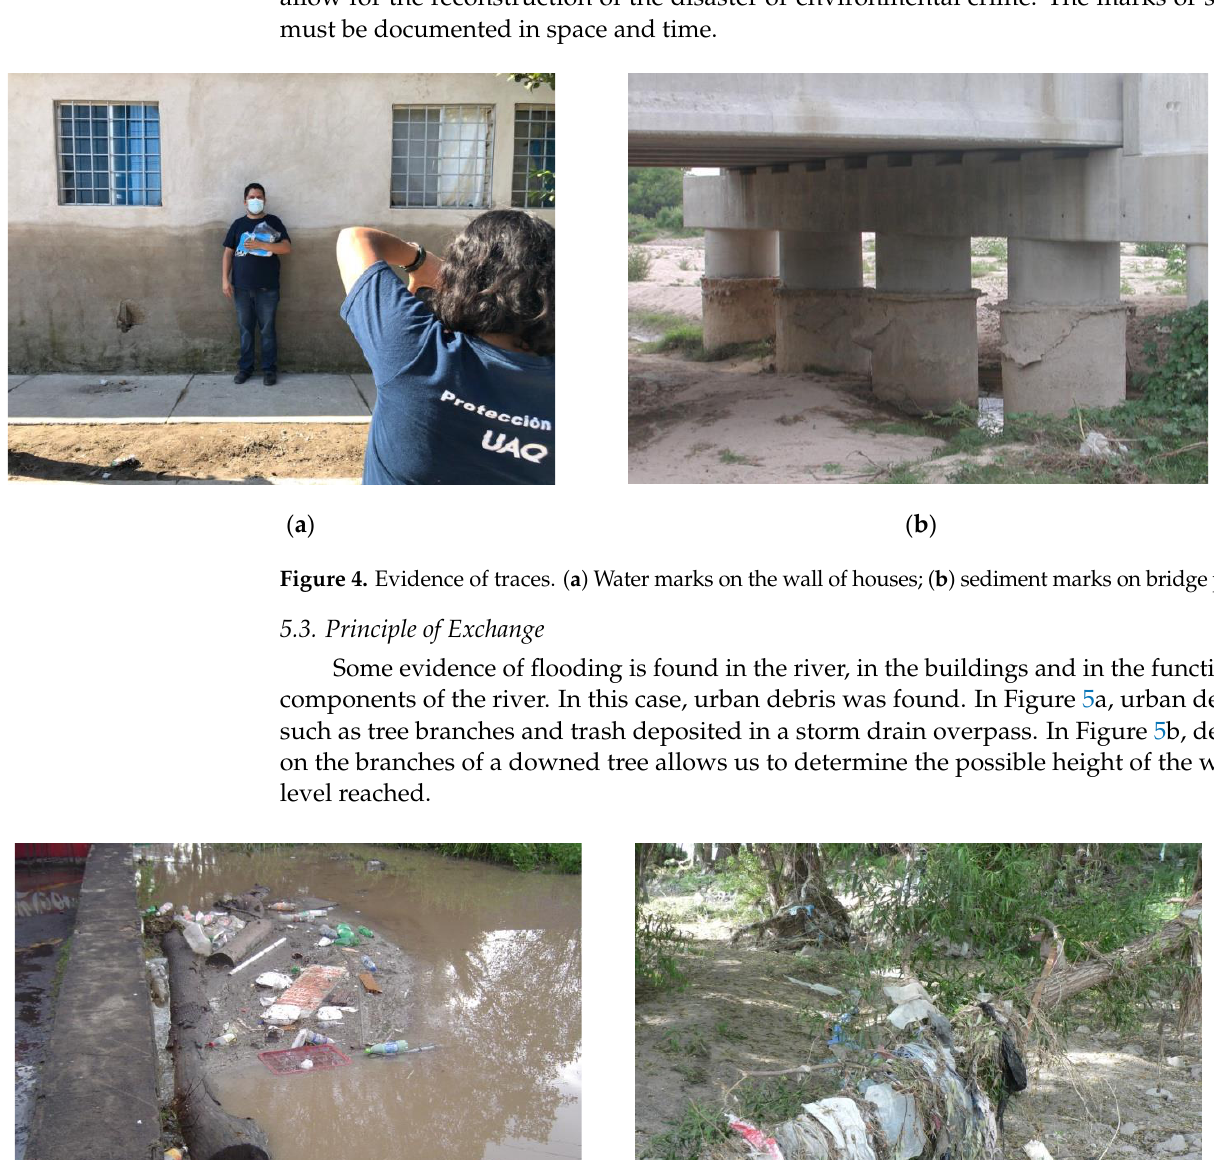
Figure 3. Evidence of extreme rainfall. ( a ) Urban flooding; ( b ) storm drainage working at pressure.